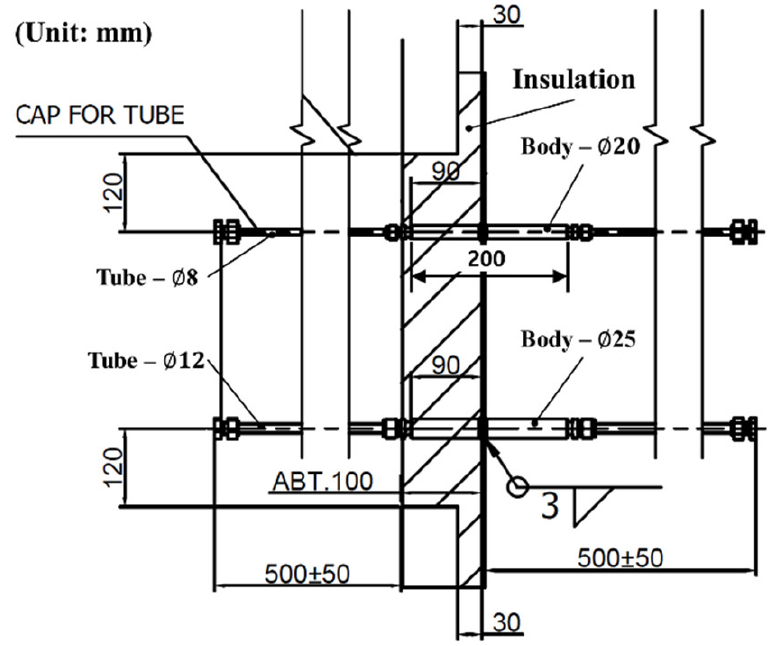
Figure 2. Enhanced design configuration of A60 BPP.